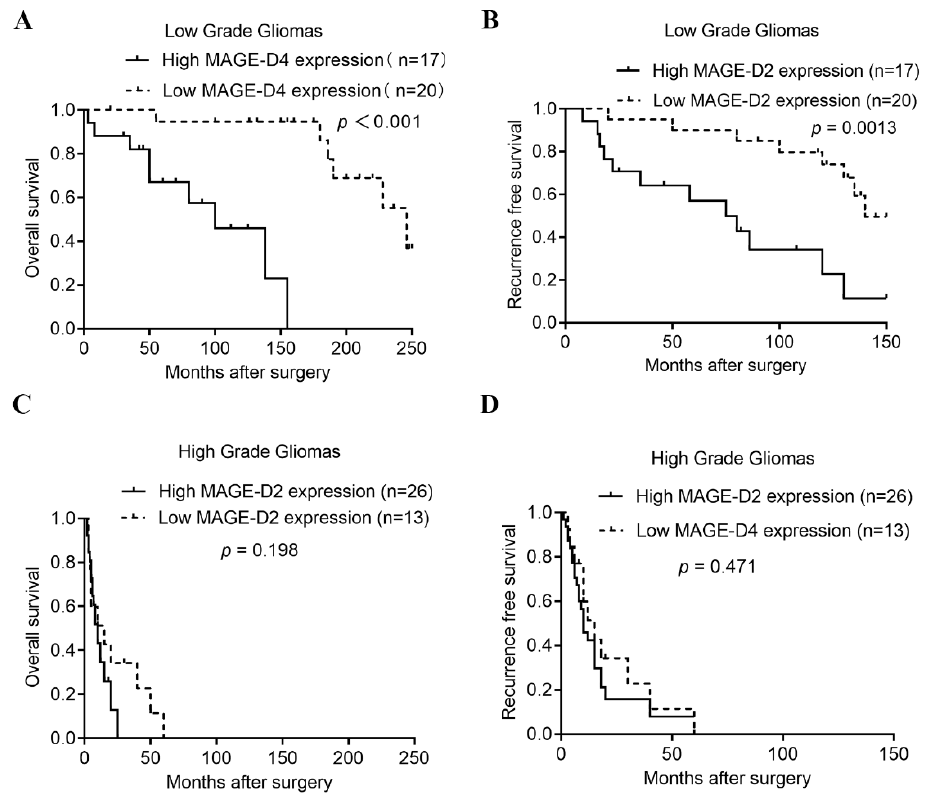
Figure 4. Kaplan–Meier curves showing the survival of glioma patients with different MAGED2 expression levels. ( A – D ) Kaplan–Meier survival curves plotting OS and RFS times according to MAGED2 staining in low-grade ( A , B ) and high-grade gliomas ( C , D ). Mantel–Cox log rank test was performed to determine the p -value indicated on the graphs. RFS, recurrence-free survival; OS, overall